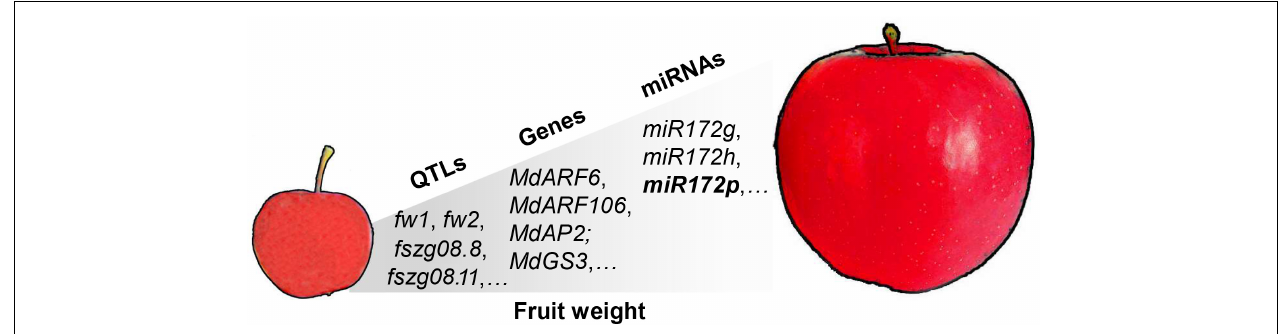
FIGURE 1 | Quantitative trait loci (QTLs), molecular markers, major-effect genes, and miRNAs associated with apple fruit weight. The main QTLs associated with fruit weight include fw1 , fw2 , and fszg08.8 (Devoghalaere et al., 2012; Chang et al., 2014). The major-effect genes include the auxin response factors MdARF6